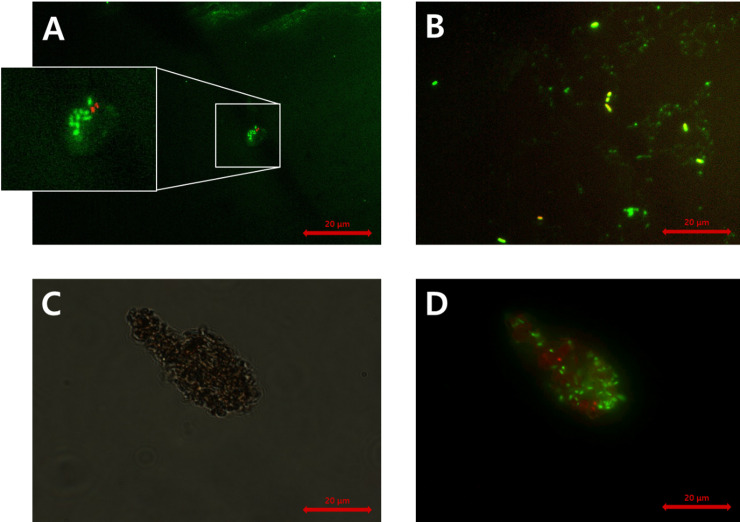
Photographs of bacteria and soil particles under EM.The photographs of A and B show bacterial cells in the garden soil samples filtered through 10 μm filters, and those of C and D show bacterial cells attached on the soil microaggregate in the soil samples without filtration. The photograph of C was taken under differential interference contrast (DIC) mode, whereas those of A, B, and D were taken under fluorescence mode. Live cells, dead cells, and damaged cells are shown in green, red, and yellow, respectively. The samples were stored at 4°C and pretreated by vortexation at maximum speed for 5 min, sonication at 300 W for 3 min, and centrifugation at 1400 × g for 15 min.